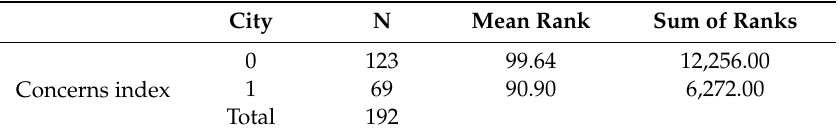
Table 14. Ranks concerns index and city.